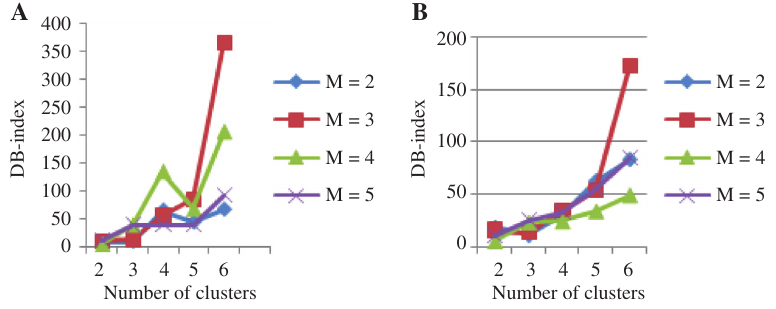
Figure 3: DB-Index Analysis Using (A) Dataset 1 and (B) Dataset